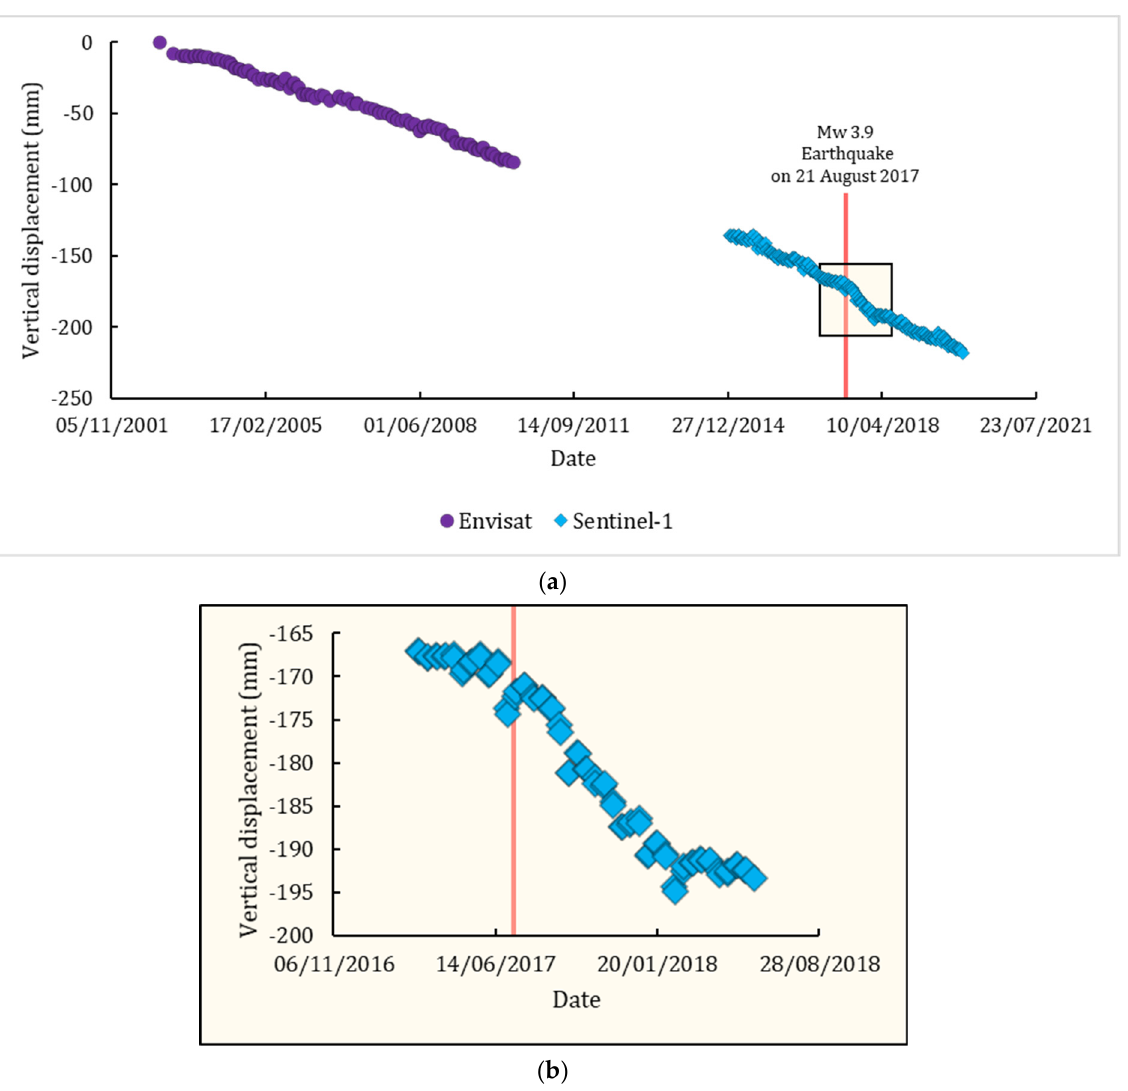
Figure 13. ( a ) Time series of vertical displacements plotted at the centre of the maximum deformation area identified by the totality of the elaborations and derived from Envisat (11/2002–06/2010) and Sentinel-1A (01/2015–12/2019) processing. ( b ) Detail of the acceleration recorded by the Sentinel-1A sensor following the 21 August 2017 earthquake (red line).